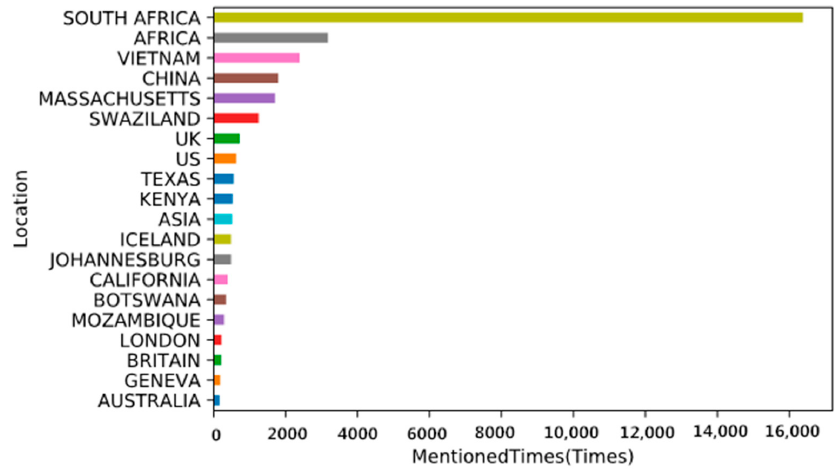
Figure 8. Location information mentioned in tweets.